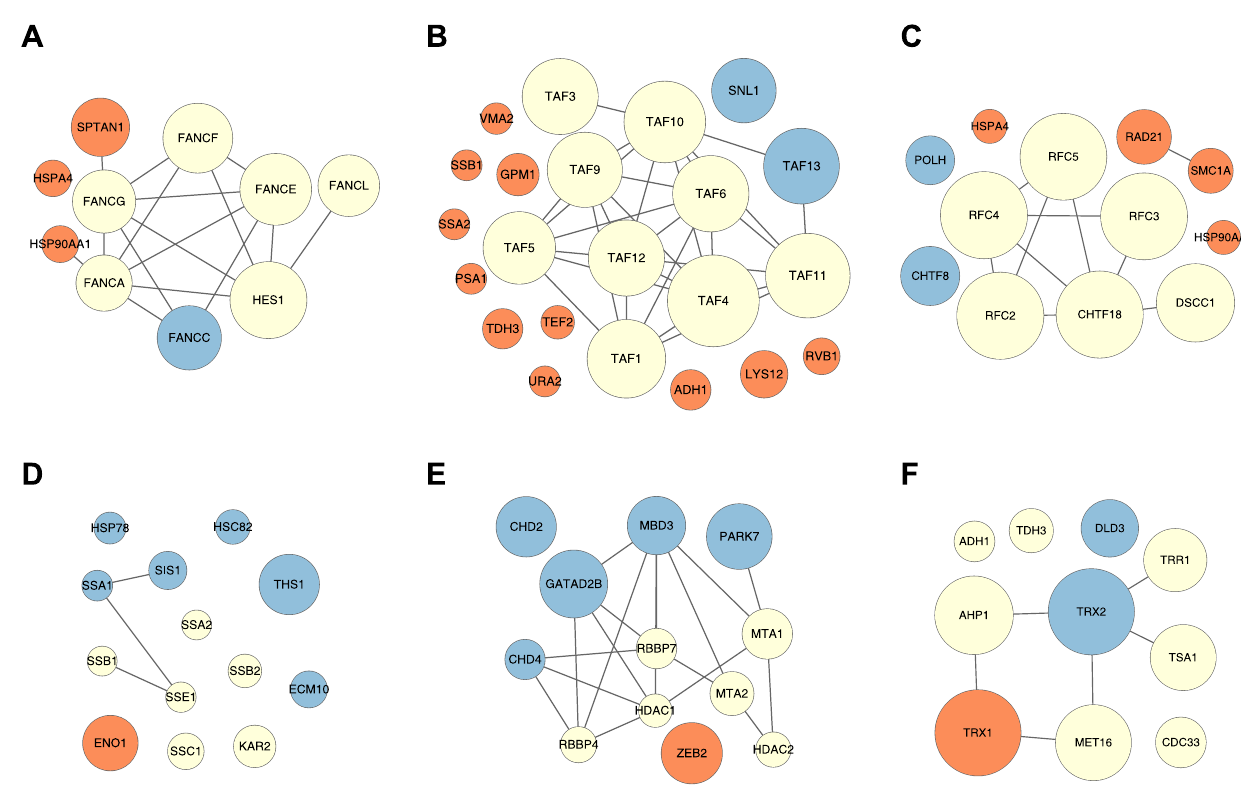
Figure 4. Examples of conflicting embeddings of complexes with respect to support and information flow weights. In each case a ‘smaller’ complex (X) embeds ( ? ) into a ‘larger’ one (Y) under one model but not the other. Each panel shows the union of proteins from both complexes linked by their direct interactions. Protein information flow weights are approximately indicated by the area of the corresponding nodes; the support weights of all proteins are equal. Proteins present only in X are colored red, those present only in Y are colored blue, while those belonging to both X and Y are displayed lightly colored. Top row ( A , B , C ) shows the cases where X ? Y under information flow but not under support weights. A Members of the human Fanconi anaemia nuclear complex form a well-connected core of both X and Y. While Y contains an additional member of the same complex (FANCC), X includes two chaperones and one cytoskeletal protein that have significantly smaller weights than the shared core. Note that Y just fails to embed into X under a ~ 0 : 15 because the weights of the core proteins are somewhat larger in Y than in X due to interactions with FANCC not present in X. B Yeast TFIID complex is well-characterized through direct interactions. Hence, even though X contains 11/20 sticky proteins (mostly chaperones), it still embeds into Y. C Different manifestations of the human DNA replication factor C retrieved using the same bait protein. In this case both X ? Y and Y ? X, so X and Y would form a merged complex in the final hierarchy. Bottom row ( D , E , F ) shows the cases where X ? Y under support weights but not under information flow weights. D Gong et al. [37] systematically studied associations of yeast proteins with chaperones. In this case, X shares 6/7 proteins with B, which is sufficient for embedding under support weights. However, the one excluded protein (ENO1) is the bait for X, which carries relatively large information flow weight. E Members of the NuRD nuclear complex (light colored) are very common among evidences for human complexes and thus carry small information flow weights despite being well connected. Here, they appear as preys to transcription factor ZEB2 and multifunctional peptidase PARK7, which need not be very closely functionally related. F Yeast TRX1 and TRX2 are highly homologous isoenzymes that form a part of the cytoplasmic thioredoxin system. Although they share the same binding partners, they do not appear together in a complex and thus it is not appropriate to consider X a part of